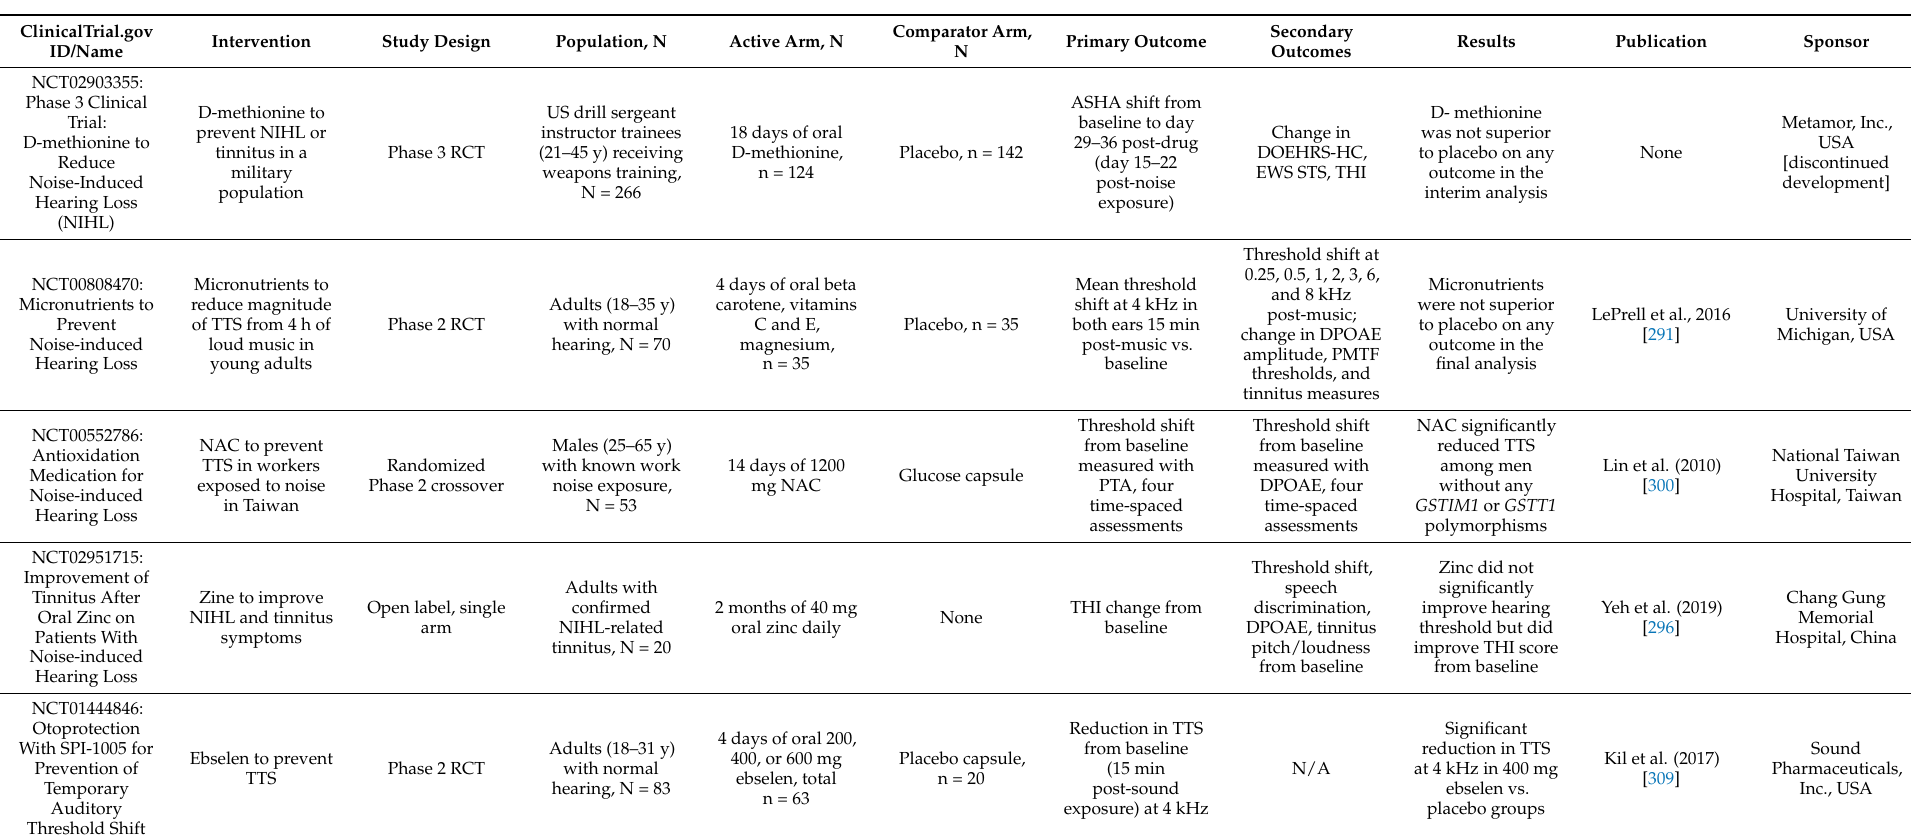
Table 2. Completed clinical trials of interventions for NIHL registered at ClinicalTrials.gov with reported